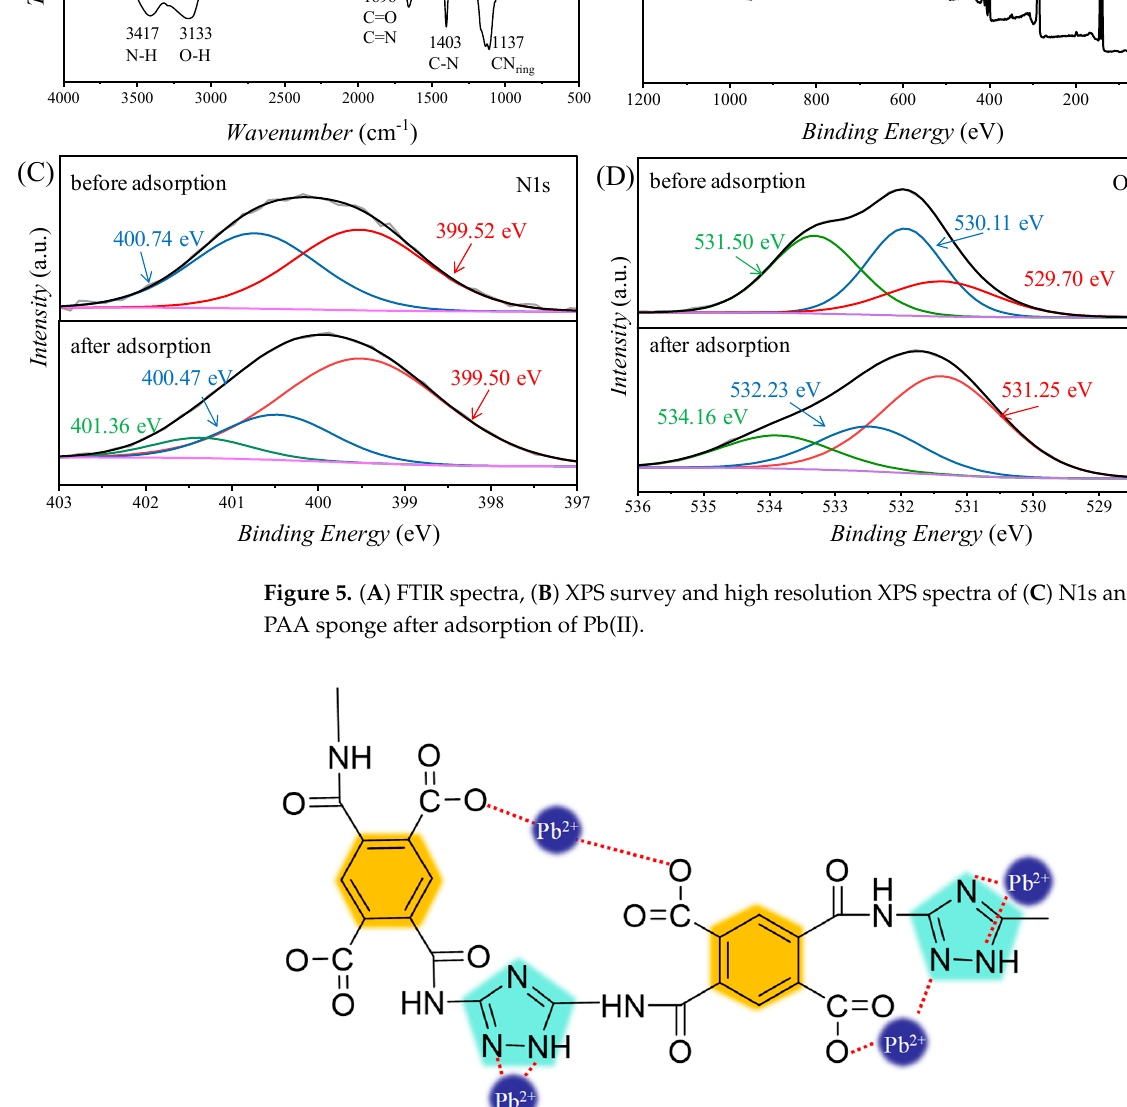
Figure 6. Schematic illustration of the adsorption mechanism of Pb(II) by PAA sponge.